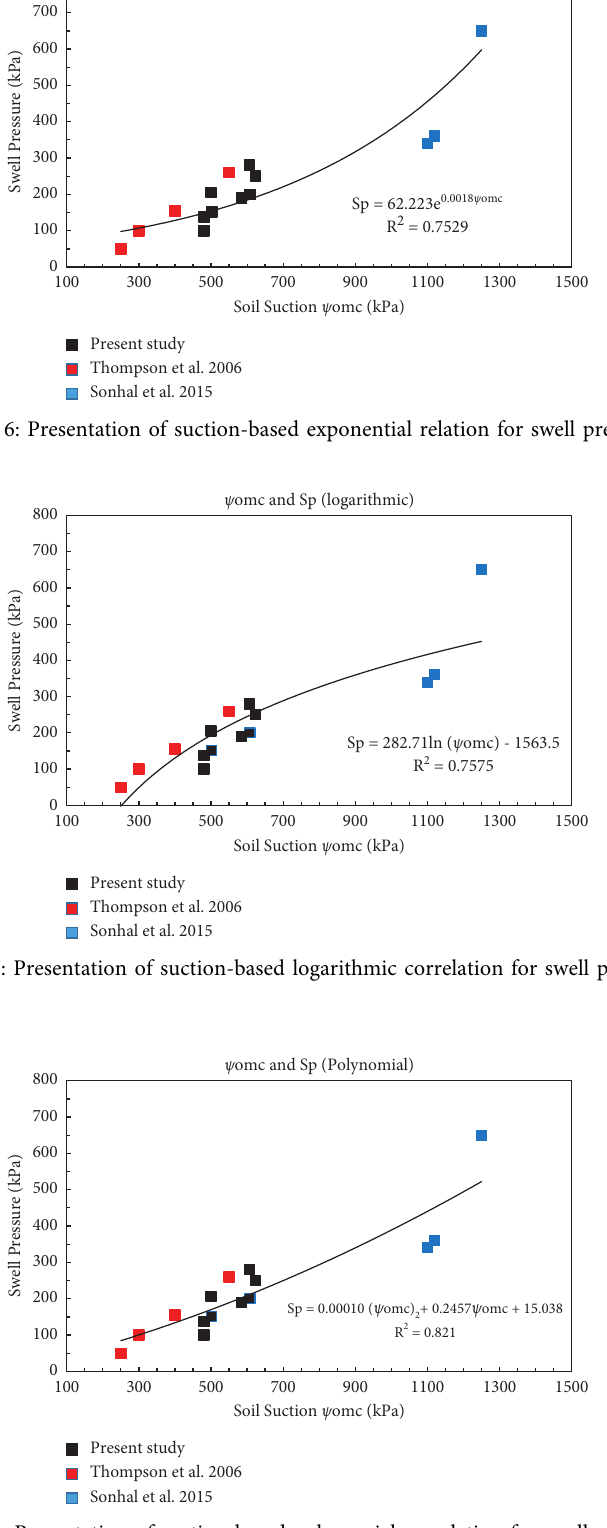
Figure 8: Presentation of suction-based polynomial correlation for swell pressure.